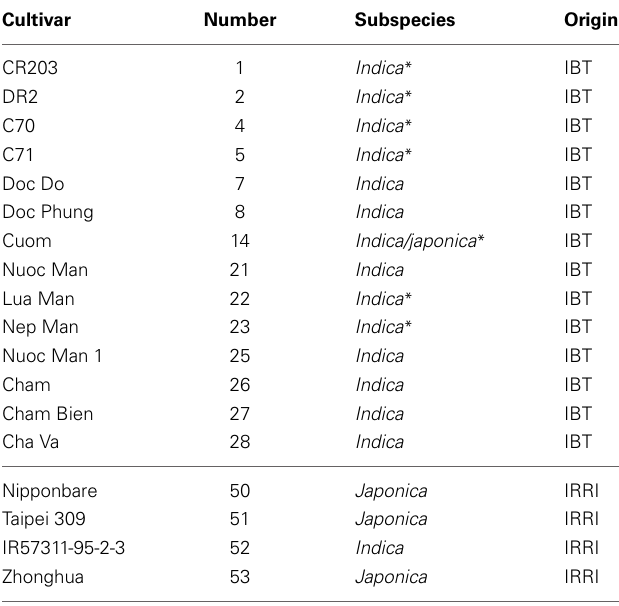
Table 1 | List of cultivars of Oryza sativa L. used for salt stress